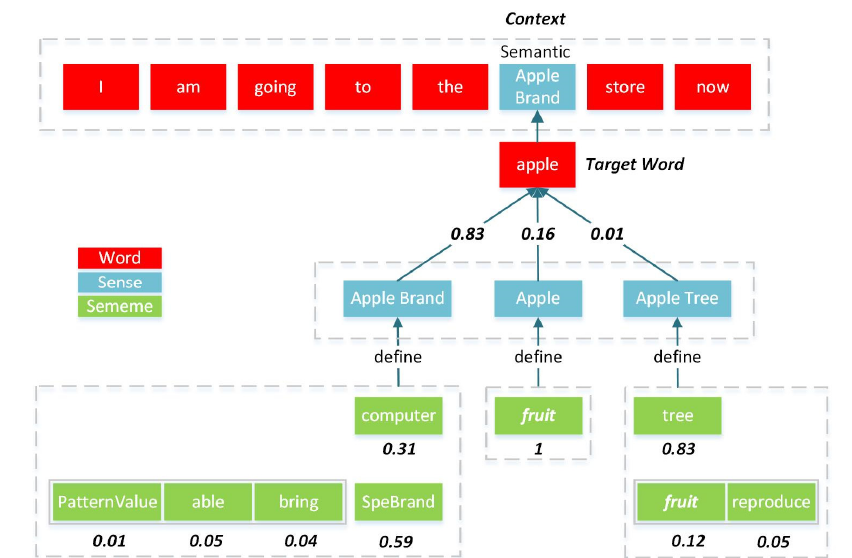
Figure 2. Interpretation of weight changes of sense and sememe. Sense means the meaning that exists within the word and does not change with the context, but its semantic contribution to the word is different in different contexts. For example, the word “Apple” has three different “senses”: “Apple Brand”, “Apple (Fruit)” and “Apple Tree”. In the context “I am going to the ~ store now.”, the semantic of the word “apple” tends to the sense “Apple Brand”. The sememe’s contribution to the sense should be different.